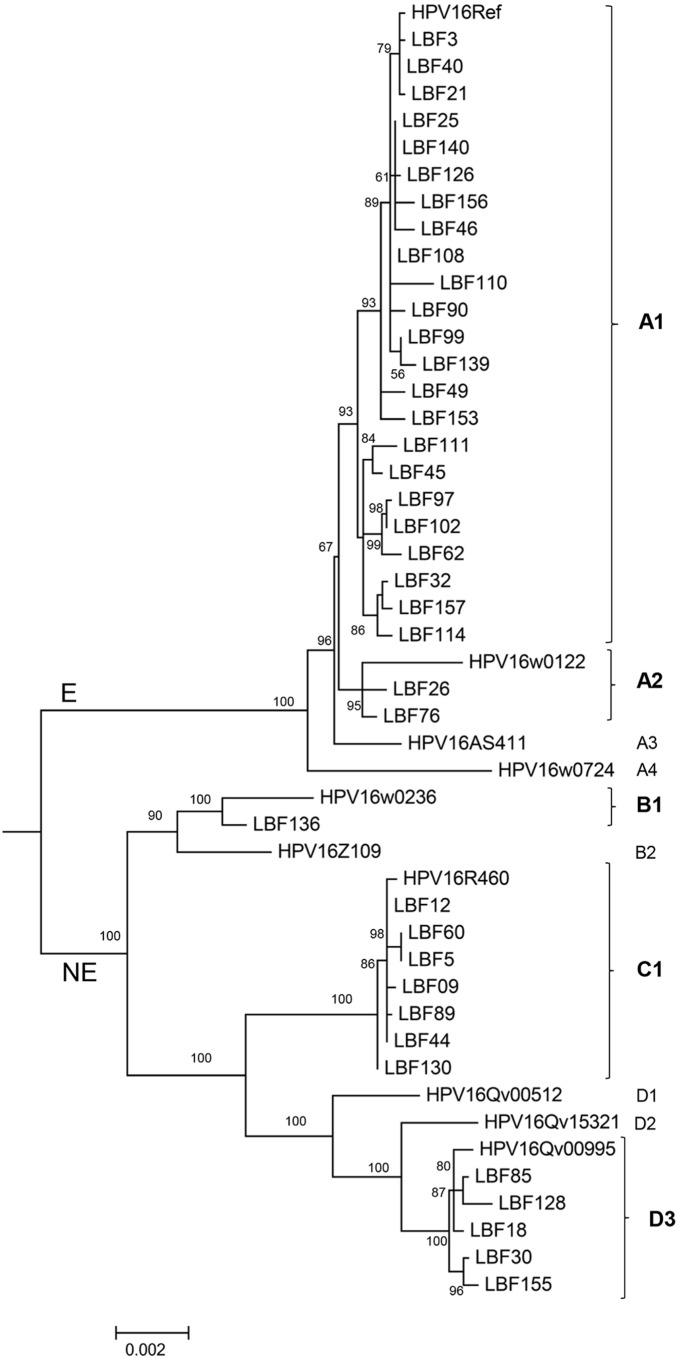
Tree topology.Phylogenetic tree was inferred from global alignment of complete and partial genome nucleotide sequences. Distinct variant lineages (i.e., termed A, B, and C) are classified according to the topology and nucleotide sequence differences from >1% to <10%; distinct sublineages (e.g., termed A1 and A2) were also inferred from the tree topology and nucleotide sequence differences in the >0.5% to <1% range [22].